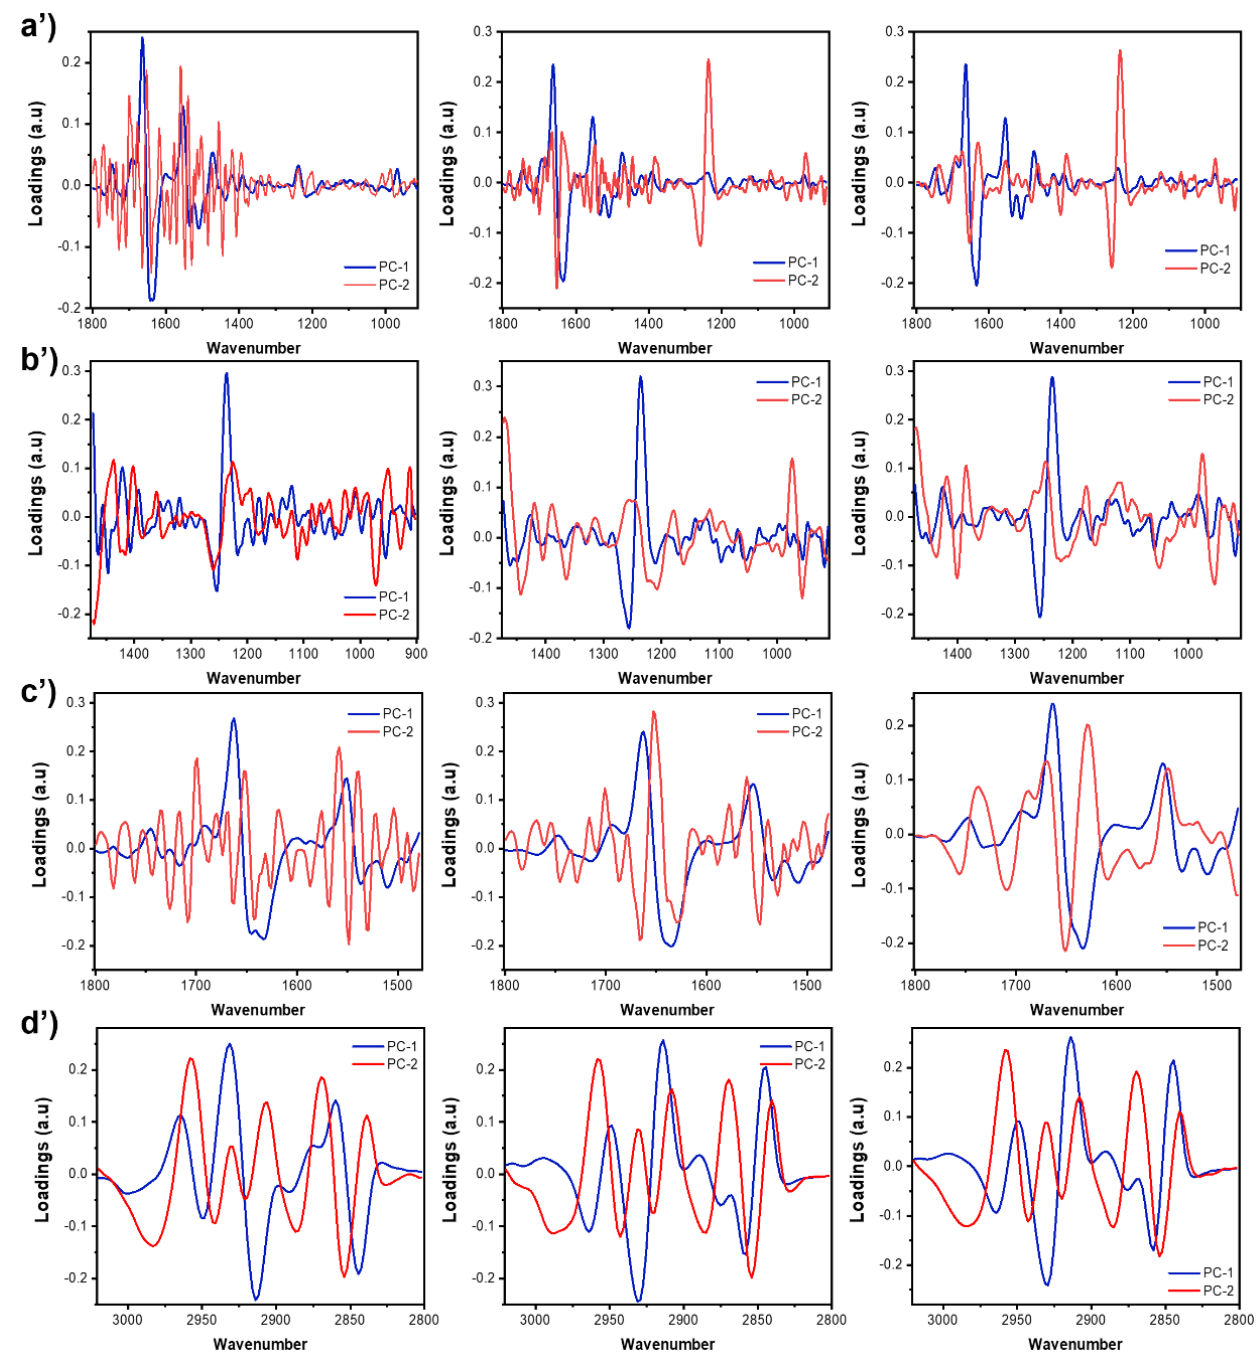
Figure 9. Principal component analysis (PCA) score plots ( a – d ) and loading plots ( a’ – d’ ) from 2nd derivative spectra of groups of treated Saos-2 cells. Biochemical changes from each biochemical group were discriminated considering the PC1 versus PC2 score plot: ( a , a’ ) fingerprint, ( b , b’ ) DNA and glucids, ( c , c’ ) proteins and ( d , d’ )